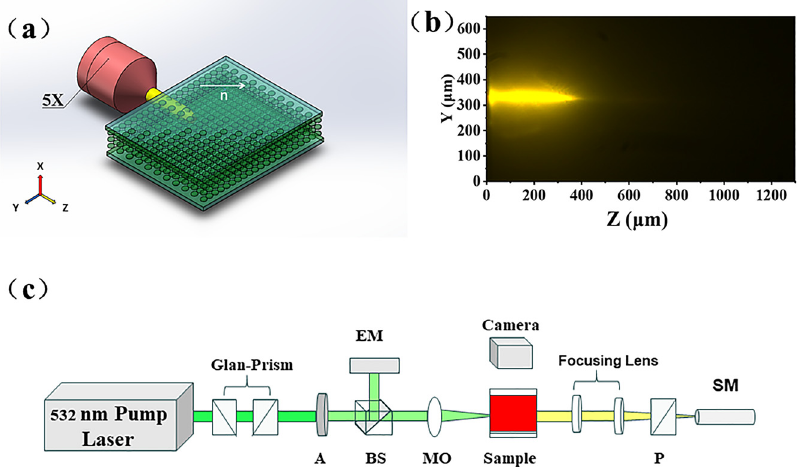
Figure 1: (a) Cell configuration and LCMs orientation; (b) Beam transmission path image; (c) Experimental setup